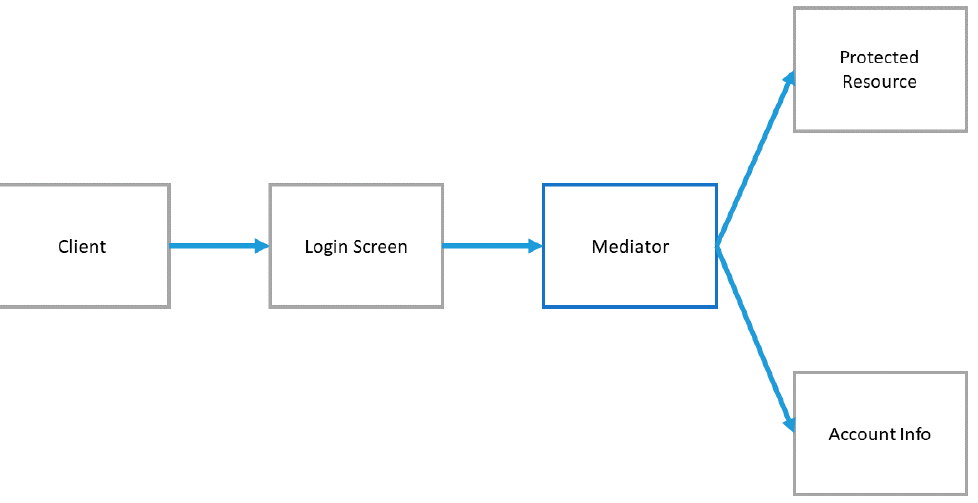
Figure 17. Conceptual overview of Account Lockout pattern